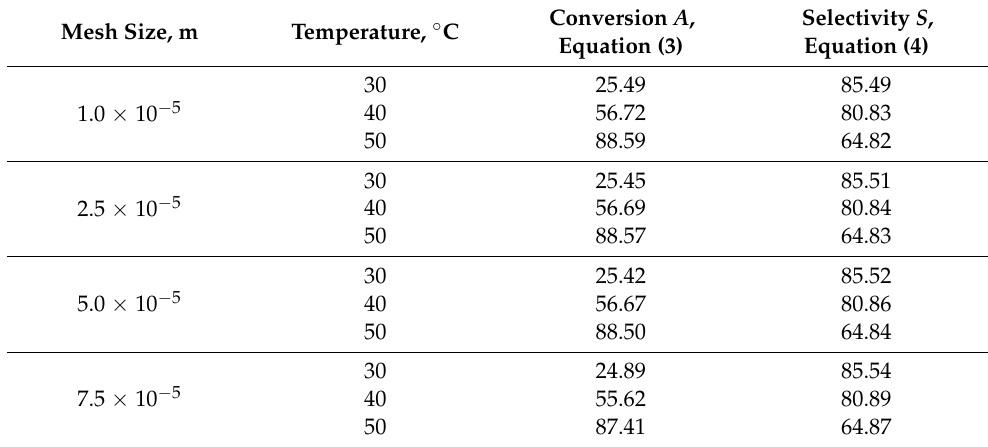
Table 1. Mesh selection analysis.